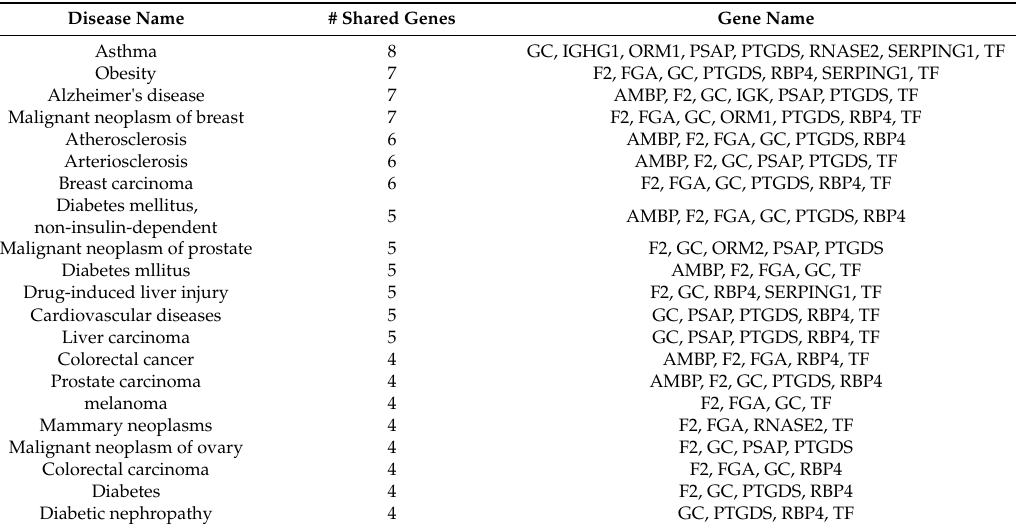
Table 3. DisGeNET disease analysis for the ERT